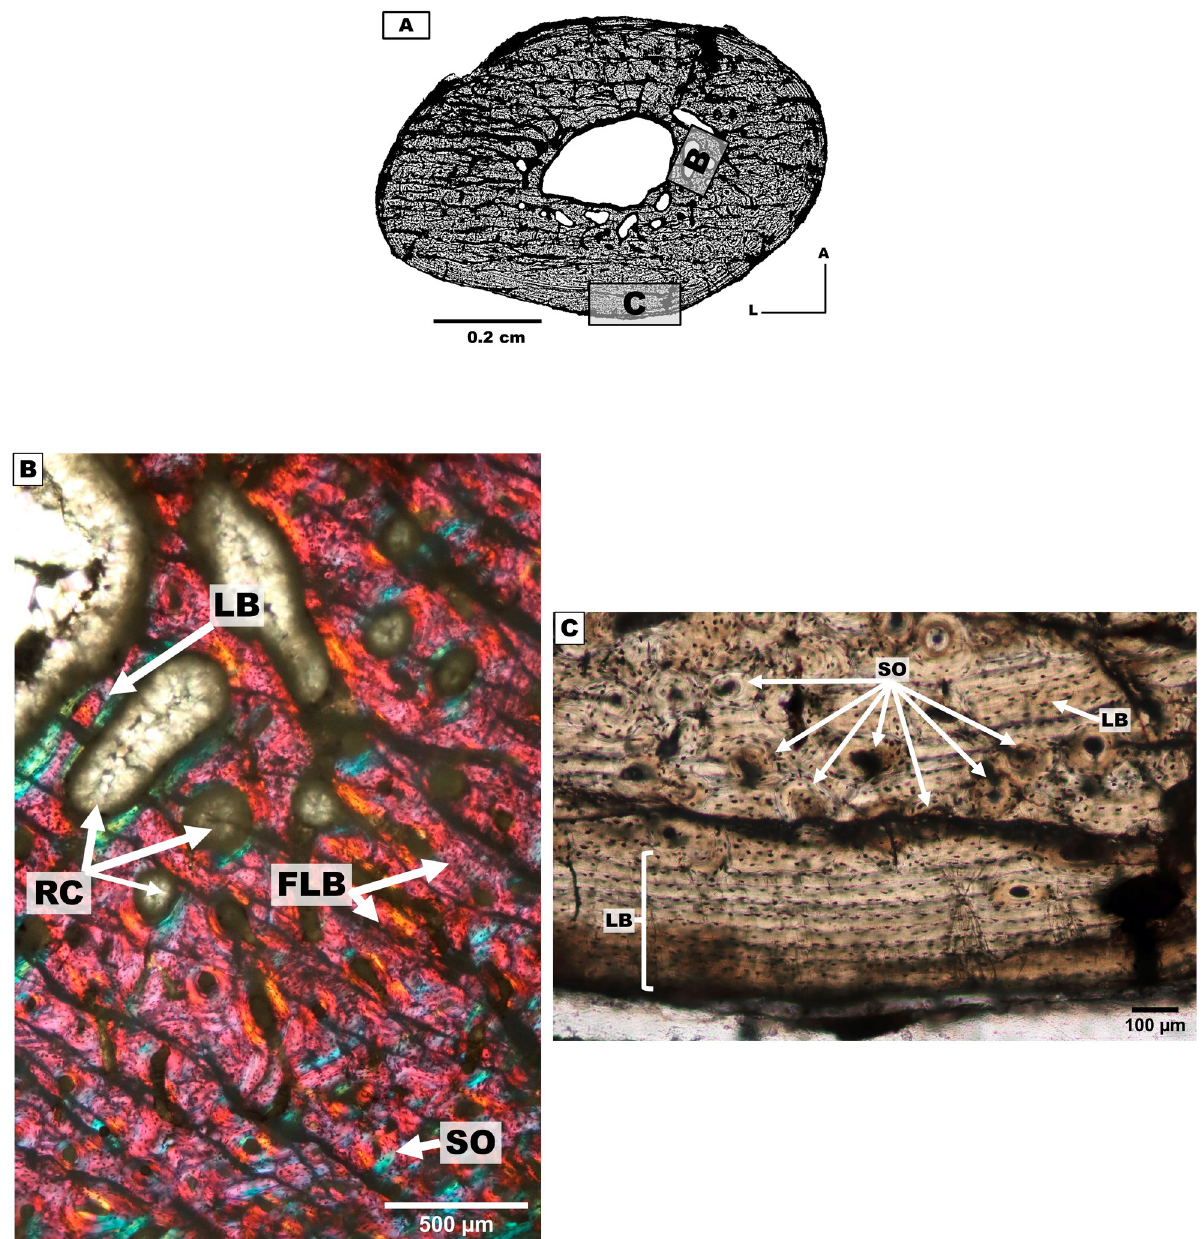
Fig 10. Metatarsal II cross-sections of the mesotheriine notoungulate Caraguatypotherium munozi from the middle Miocene of Caragua, Huaylas formation. (A) Metatarsal cross-section for individual 4 (GEOUACH.HS. MTSI.1); (B) RC and LB in the endocortical region, presence of SO in the endocortical region and FLB in the interstices (GEOUACH.HS. MTSI.1); (C) LB in the pericortical region, SO in the intracortical region (GEOUACH.HS. MTSI.1). For abbreviations refer to Fig